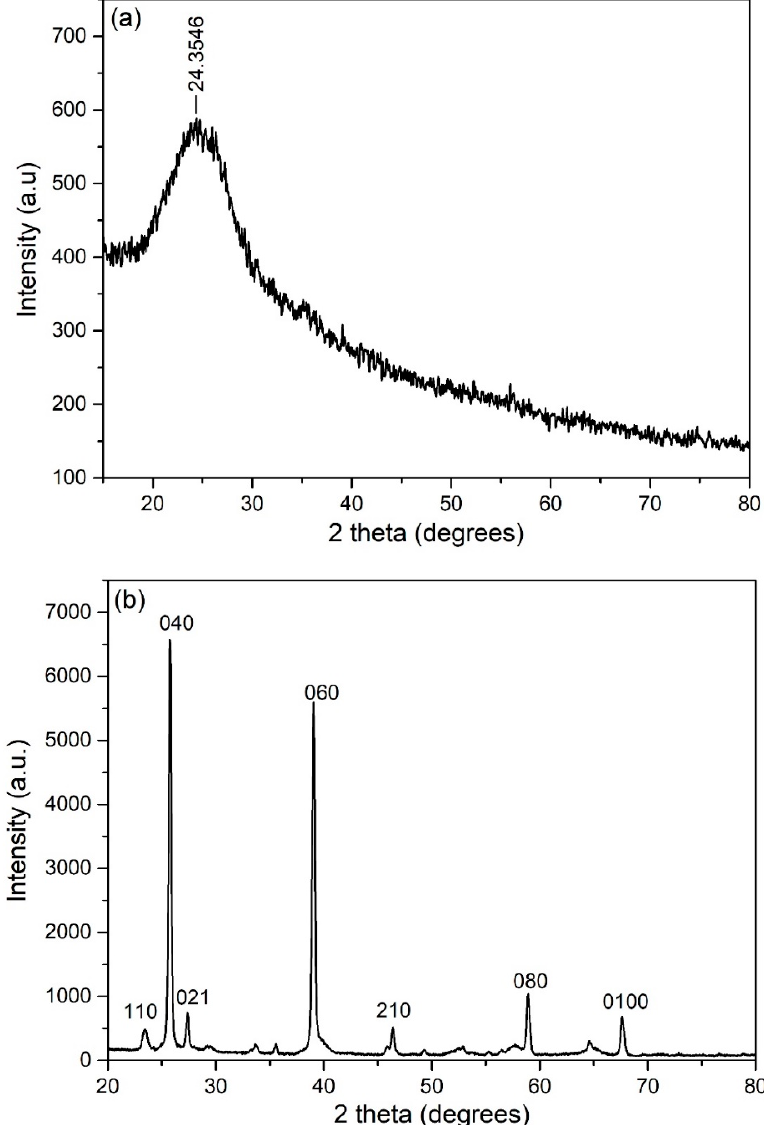
Figure 6. XRD patterns of: ( a ) Pure PPy; ( b ) MoO 3 nanobelts.